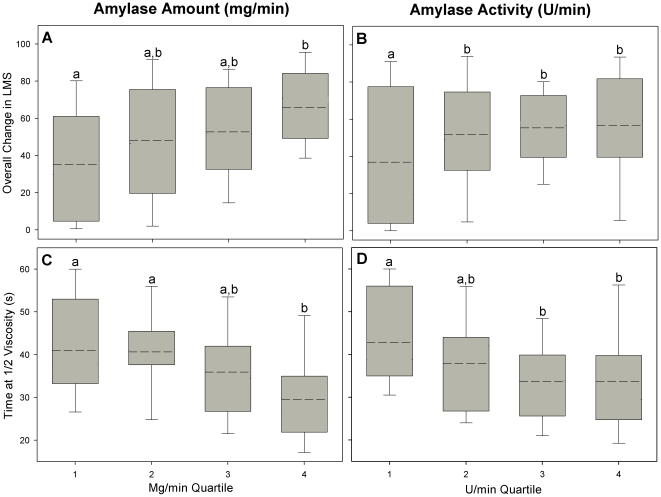
Salivary amylase levels were significantly related to perceived starch viscosity.Subjects with higher salivary amylase concentrations/ml (A) and salivary activity/ml (B) had greater overall changes in perceived viscosity. These subjects also reached ½ perceived viscosity levels significantly faster (C and D). The dashed line within each box represents the mean value, while the upper and lower boundaries of the box represent the 75th and 25th percentiles, respectively. The error bars above and below the box indicate the 90th and 10th percentiles. Points with different letters are significantly different from one another. Mg/min quartiles: 1 = 0–1.5; 2 = 1.51–2.99; 3 = 3–10; and 4 =  >10 mg/min. U/min quartiles: 1 = 0–60; 2 = 61–120; 3 = 121–220; and 4 =  >220 U/min.